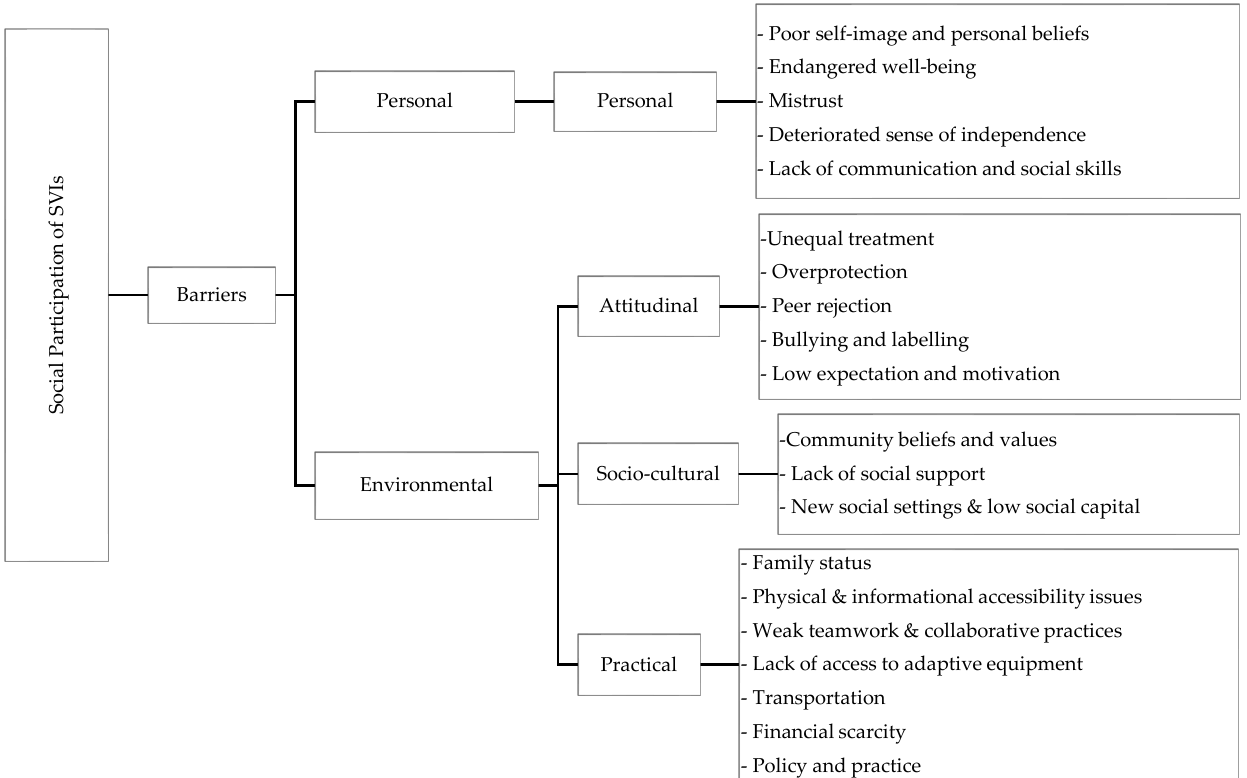
Figure 1. Themes and sub-themes which emerged from interviews with SVIs.